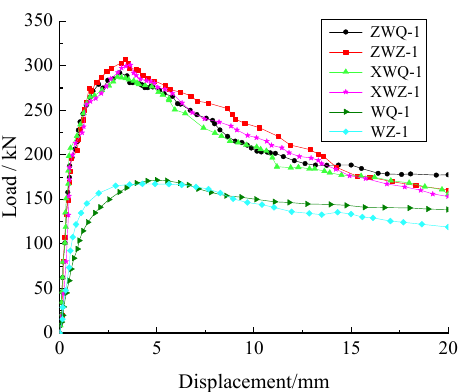
( b ) Figure 17. Stiffness–displacement curves: ( a ) common brick masonry walls; ( b ) autoclaved fly-ash- brick masonry walls. 3.3.3. Wall Materials and Seismic Performance of Walls From Table 4, the seismic performance of the autoclaved fly-ash-brick wall and the common brick wall were analyzed as follows. The load-displacement curves of those walls are shown in Figure 18, and the stiffness–displacement curves of those walls are shown in Figure 19. Without ring beams and constructional columns, the cracking, ultimate, and failure loads of the autoclaved fly-ash-brick wall WZ-1 had little difference with those of the com- mon brick masonry wall WQ-1. Meanwhile, the cracking and ultimate displacements of the autoclaved fly-ash-brick wall were less than those of the common brick wall, while the failure displacements of those walls had the opposite trend. From the ultimate load to the failure load, the ratio of the failure displacement to ultimate displacement Δ f/ Δ u of wall WZ-1 was increased by 27% compared to wall WQ-1. With the cast-in-place ring beam and the constructional column, the cracking, ulti- mate and failure loads of the autoclaved fly-ash-brick wall XWZ-1 were larger than those of the common brick wall XWQ-1. Meanwhile, the cracking displacement and ultimate displacement of the autoclaved fly-ash-brick wall were similar to those of the common brick wall.